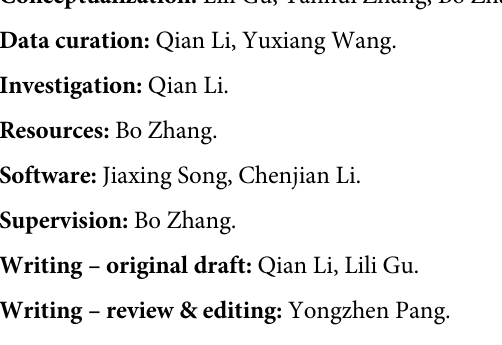
S11 Table. Significant GO enrichment terms for identified DEGs. S12 Table. Significant KEGG enrichment analysis of DEGs. S13 Table. Number of transcription factor genes in M . falcata . S14 Table. Details information of transcription factor genes that were differentially expressed. S15 Table. The DEGs related to phenylpropanoid and glycolysis/gluconeogenesis pathway. S16 Table. Information of DEGs verified by